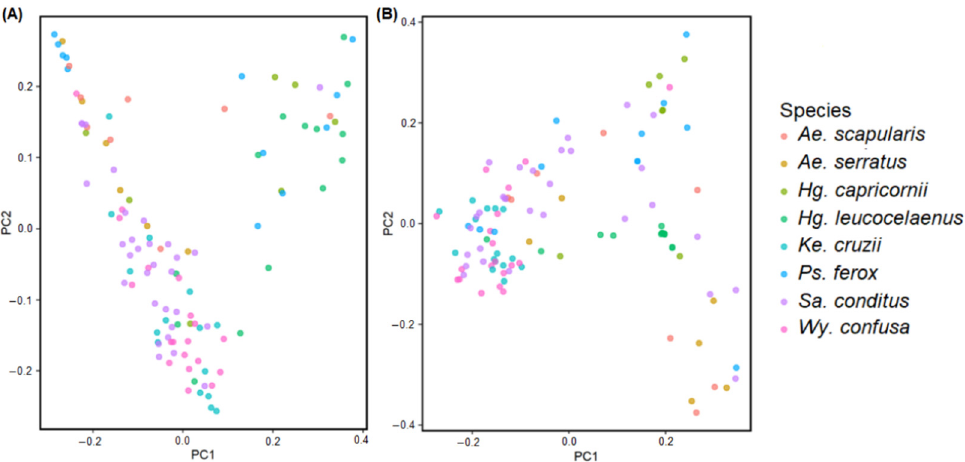
Figure 3. Principal Coordinate Analysis (PCoA) plots β diversity differences between the mosquito species. ( A ) PCoA using unweighted distance data. ( B ) PCoA using weighted distance data.